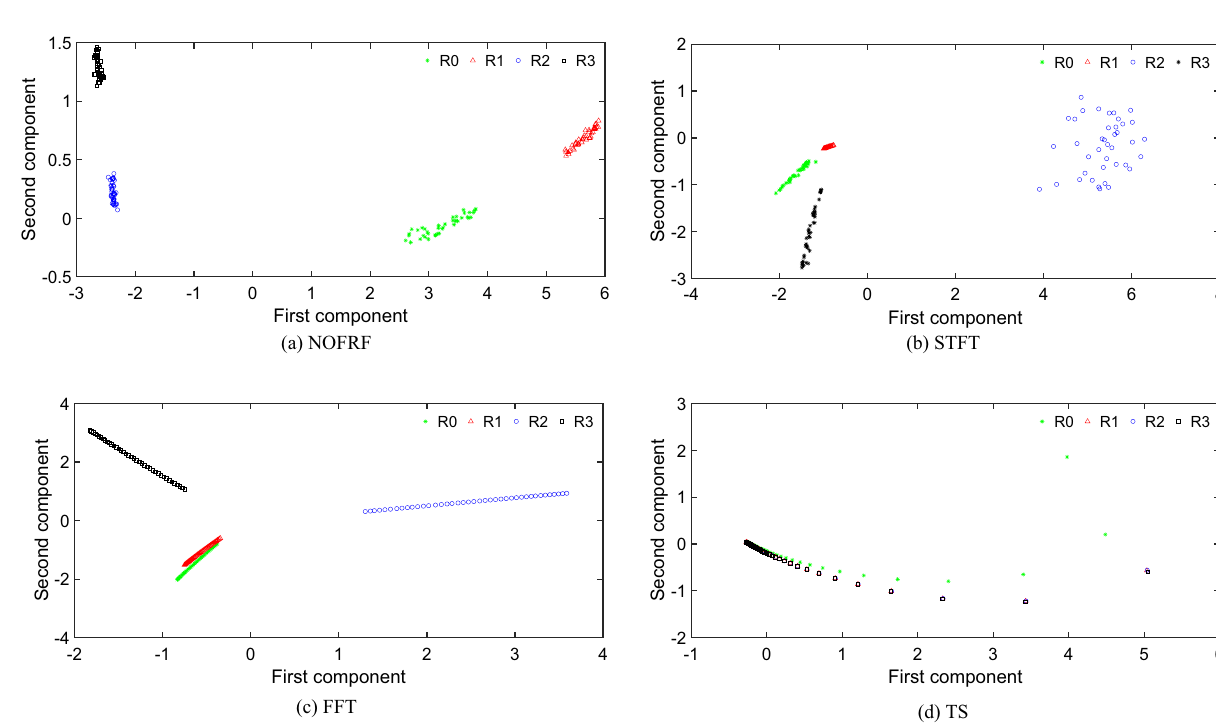
Figure 18. The visualization of different fault